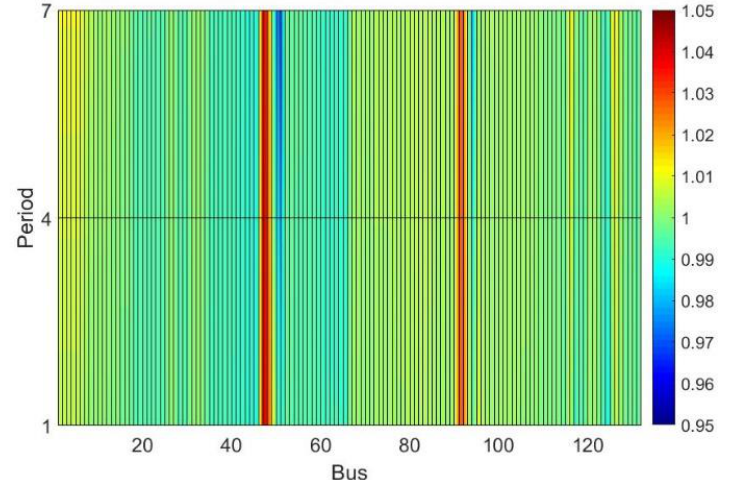
Figure 7. IEEE 123-bus system, voltage magnitudes of phase A, discrete taps, 0%